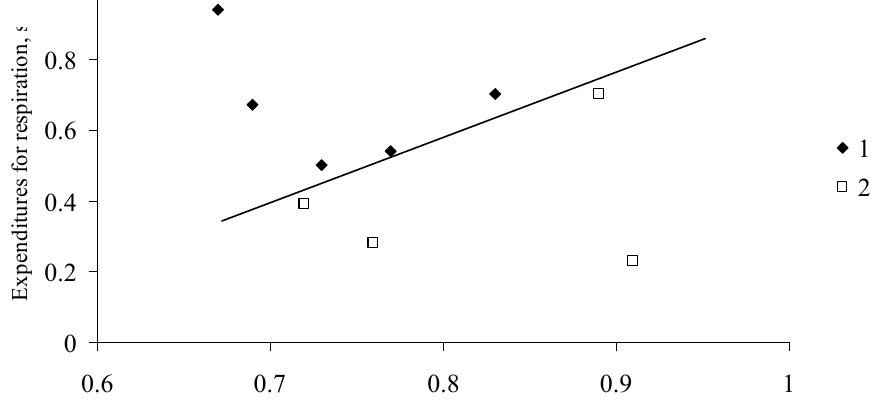
Figure 7. The relationship between coefficients (1 − α ) and s of the EcoSolow model for forest stands of different species in the northern and southern regions of Siberia. ( 1 ) in the southern regions of Siberia ( Pinus sylvestris L., Larix sibirica Ledeb., Betula pendula Roth.); ( 2 ) in the northern regions of Siberia ( Larix sibirica Ledeb., Abies sibirica Ledeb., Picea obovata Ledeb.).